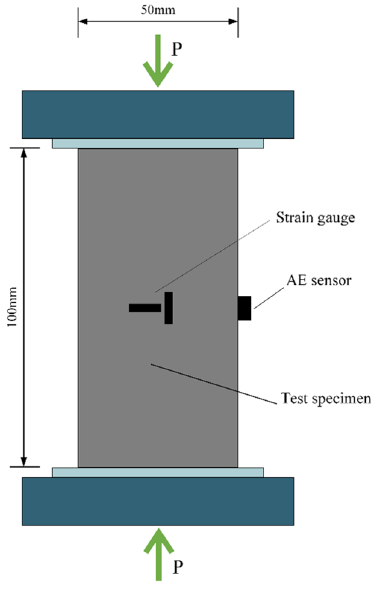
Figure 1. Testing system: ( a ) diagram of testing system; ( b ) layout of testing system.